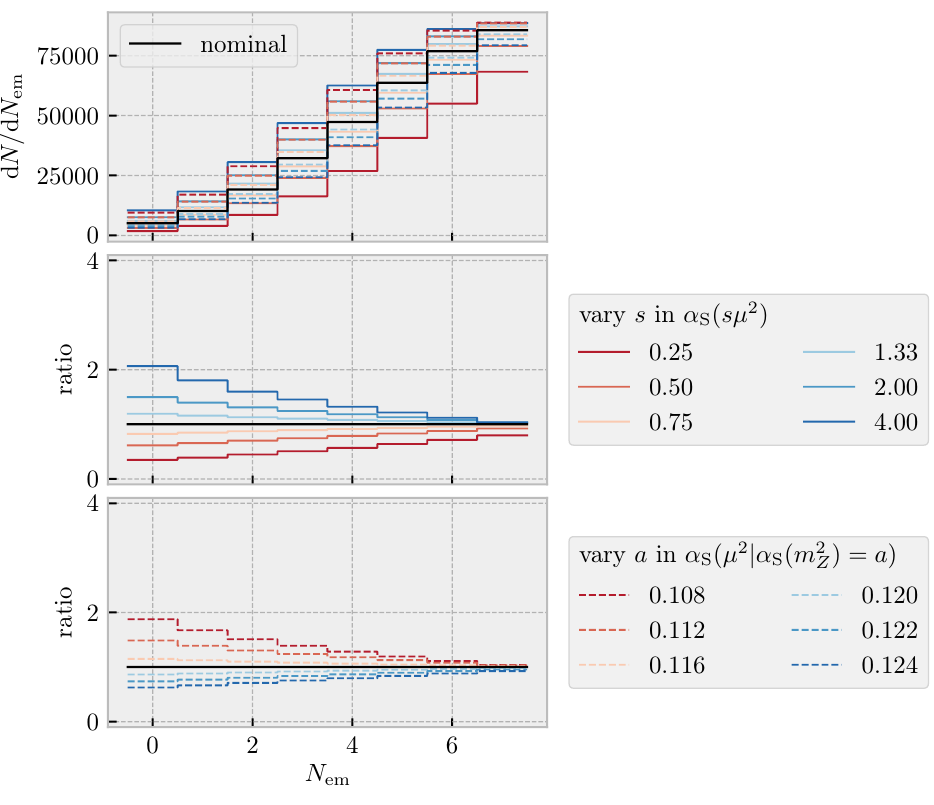
Figure 5 . The e(cid:11)ect of parton-shower (cid:11) S variations on the distribution of the number of emissions N em . The lower two panels show the ratios broken down into scale variations and (cid:11) S ( m 2 respectively. See (cid:12)gure 3 for additional